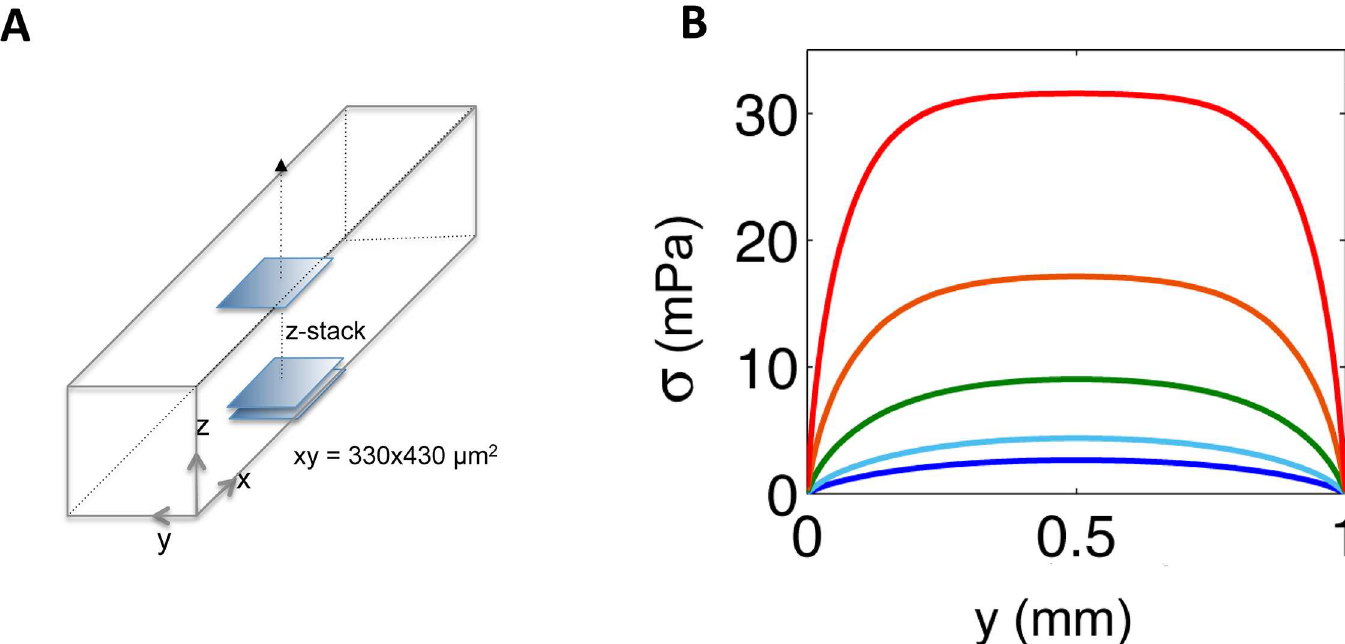
Fig 1. Shear stress significantly varies across the width of a millifluidic channel. (A) Channelblueprint.(B) Bottom shear stress values, obtainedby differentiationof the calculatedvelocity fields, are given for the 5 PDMS channelshaving a 30 mm length, 1 mm width ( y axis) and 250 μ m (red); 350 μ m (orange);500 μ m (green); 750 μ m (light blue); 1 mm (dark blue) height, under a flow rate of 1 ml/h.